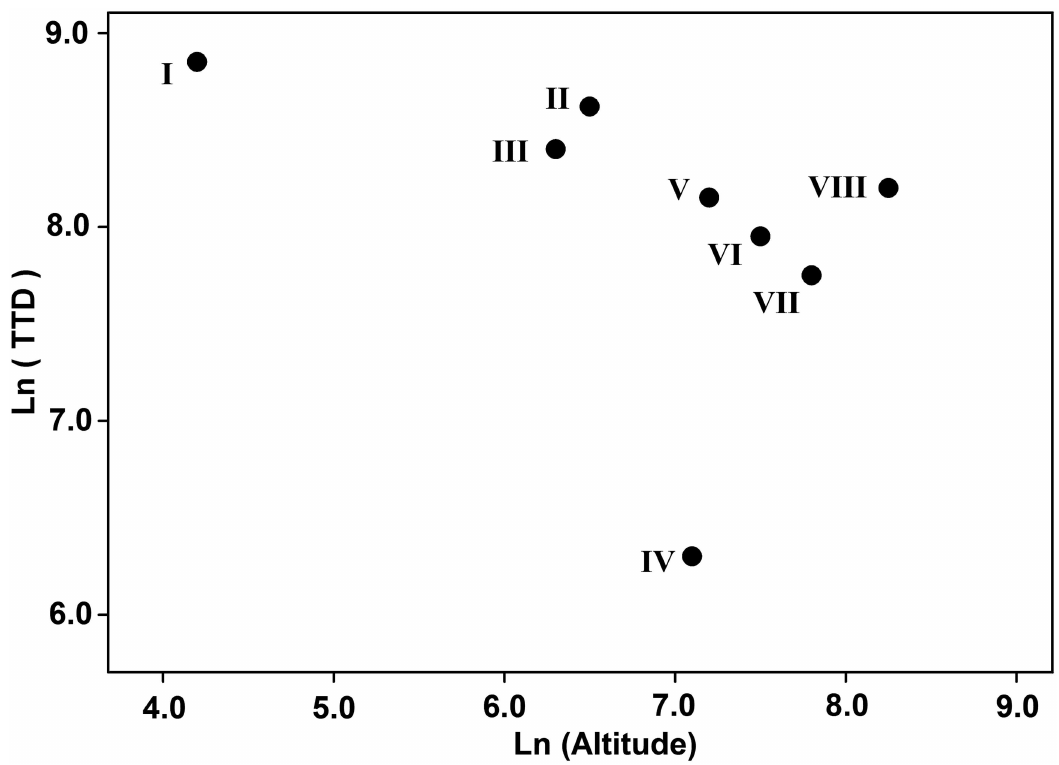
Fig 3. Relationship between latitude and Total Taxonomic Diversity (TTD) at logarithmic scale.